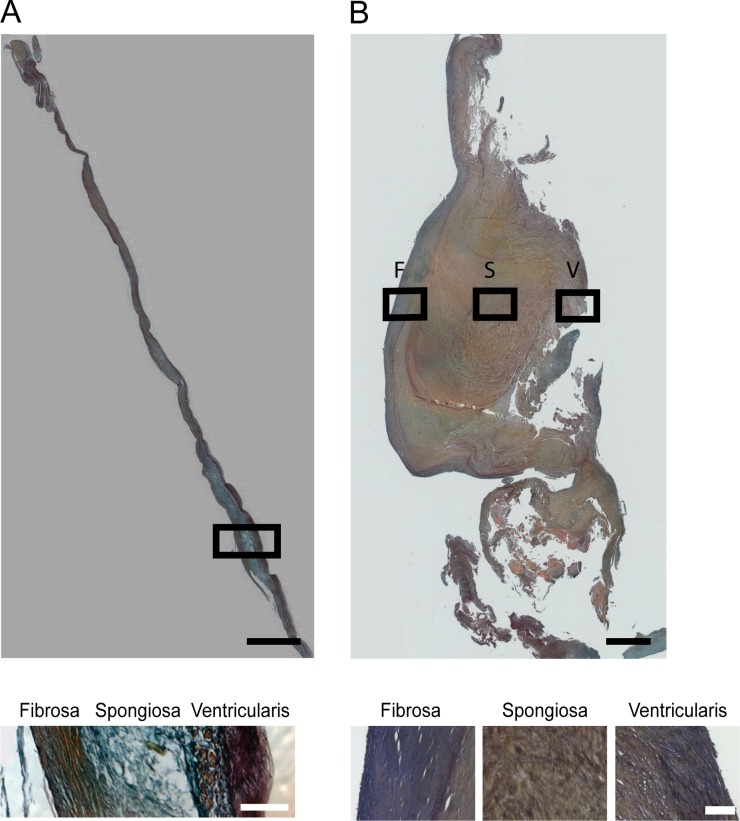
Representative images of human aortic valve leaflets stained with Movat’s Pentachrome.Top: Images of a complete leaflet are shown for a representative (A) healthy and (B) diseased valve. F = fibrosa, S = spongiosa, V = ventricularis. Scale bar = 100 μm. Bottom: Higher magnification images of the boxed area in the top images show the three leaflet layers in greater detail. Scale bar = 50 μm.